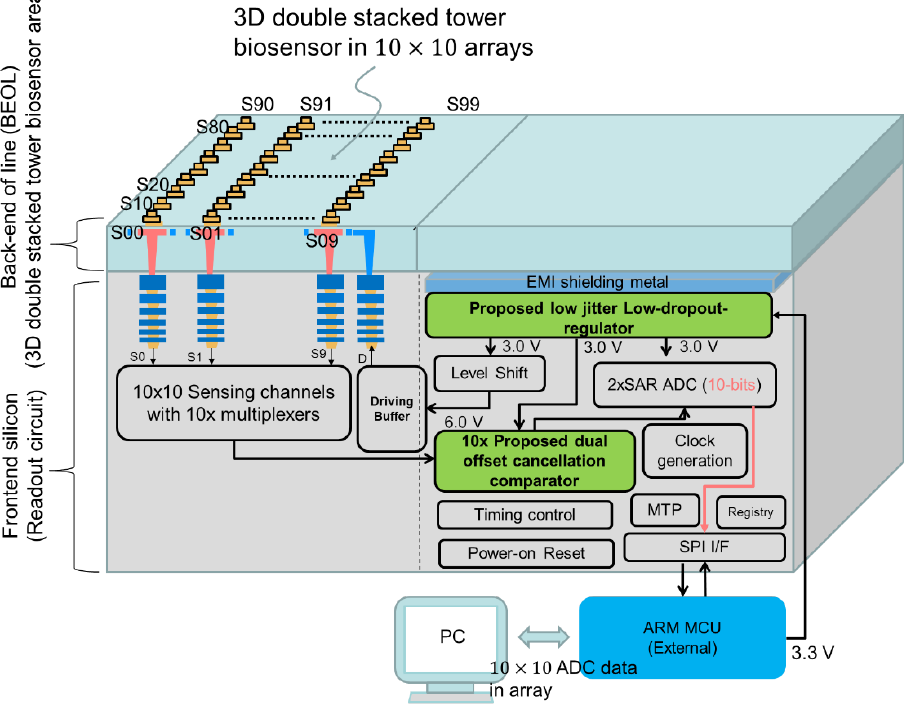
Figure 9. System architecture of readout circuit to read the capacitance change from stacked biosensor in 10 × 10 arrays. The readout circuit includes a proposed low-jitter dropout regulator, and a proposed dual offset cancellation comparator.